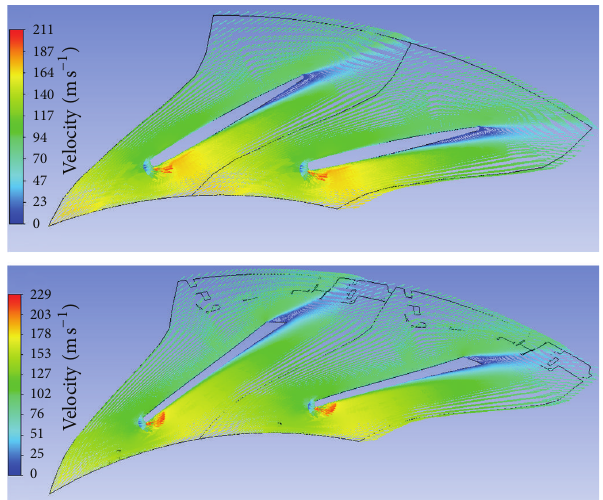
Figure 9: Velocity vectors for the midspan plane of VD (top) and CD (bottom) at 𝑖 3 ≈ 1 ∘